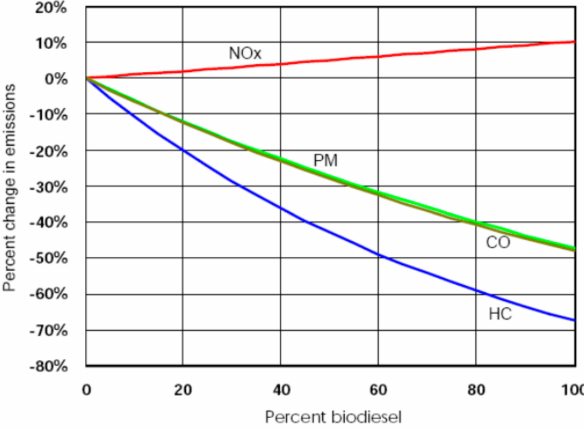
Figure 4. Trends in percentage change of pollutant emissions with biodiesel content